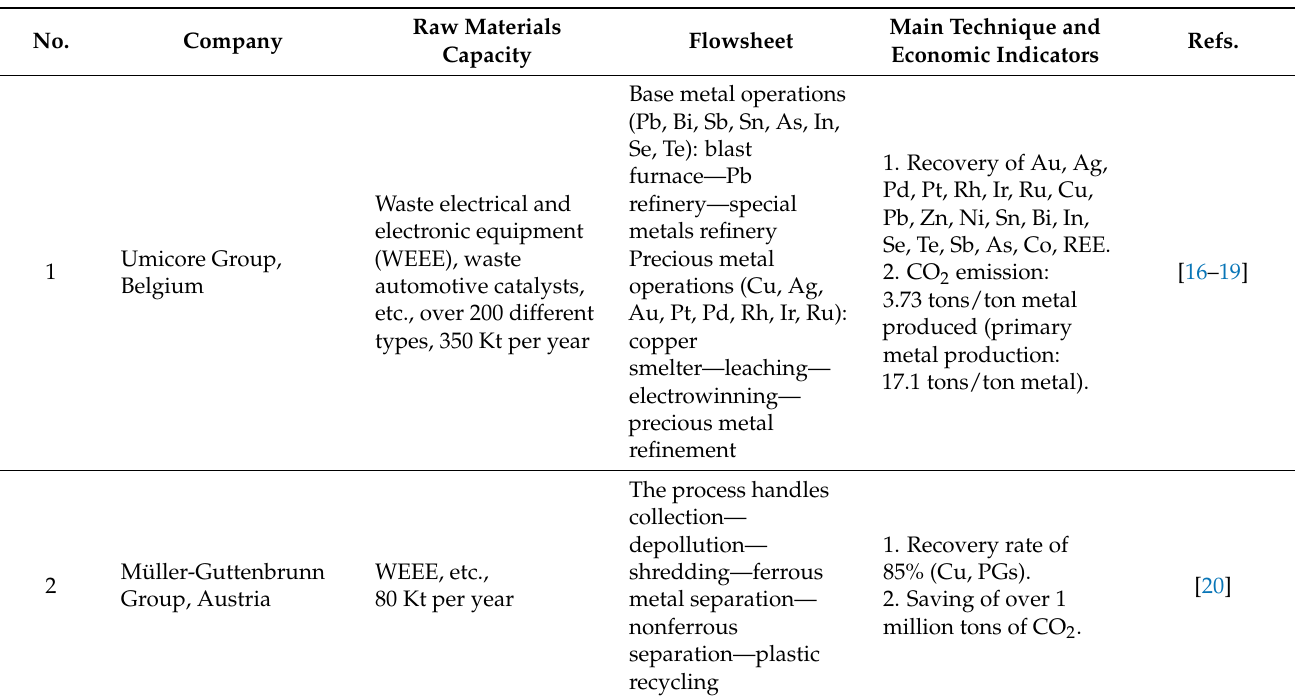
Table A1. Basic information on the typical industrial-scale E-waste treatment